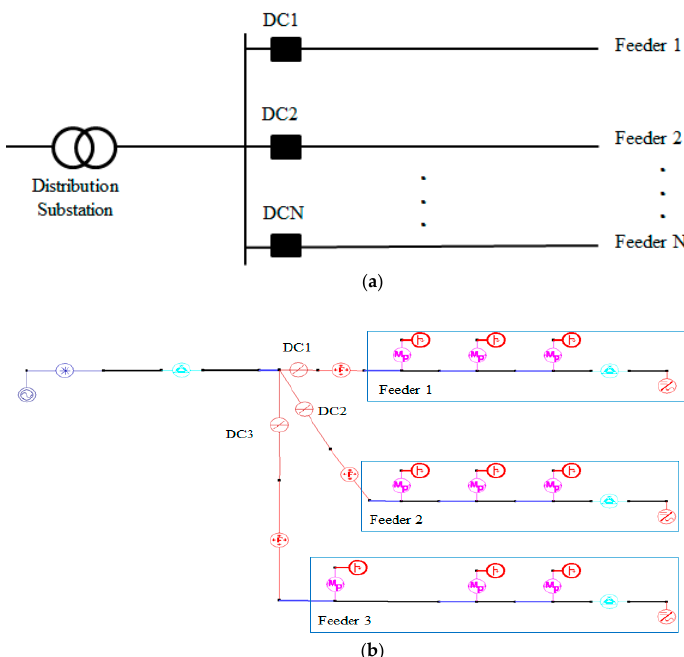
Figure 5. Structure of the distribution system for simulation ( a ) and the feeder circuit in the DEW ( b ).